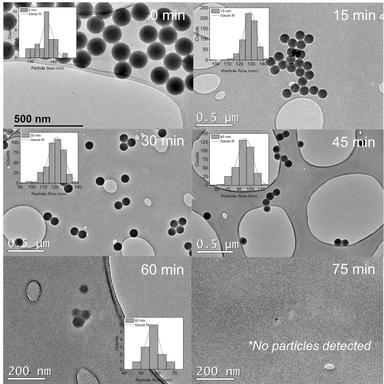
TEM analysis for the photo-Fenton oxidation of PS NPs (D0 = 140 nm; 0 = 100 mg/L; 0 = 1 mg/L; 0 = 1000 mg/L (H2O2 dosed every 30 min, 500 mg/L); pH0 = 3; T = 25 ◦C).